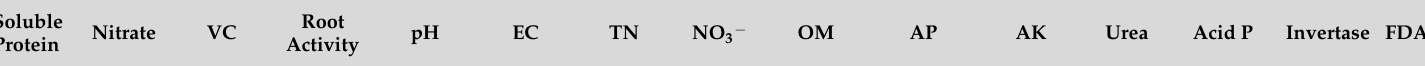
Table 6. Correlation between rhizosphere soil nutrients with yield and quality of ‘yellow rose’